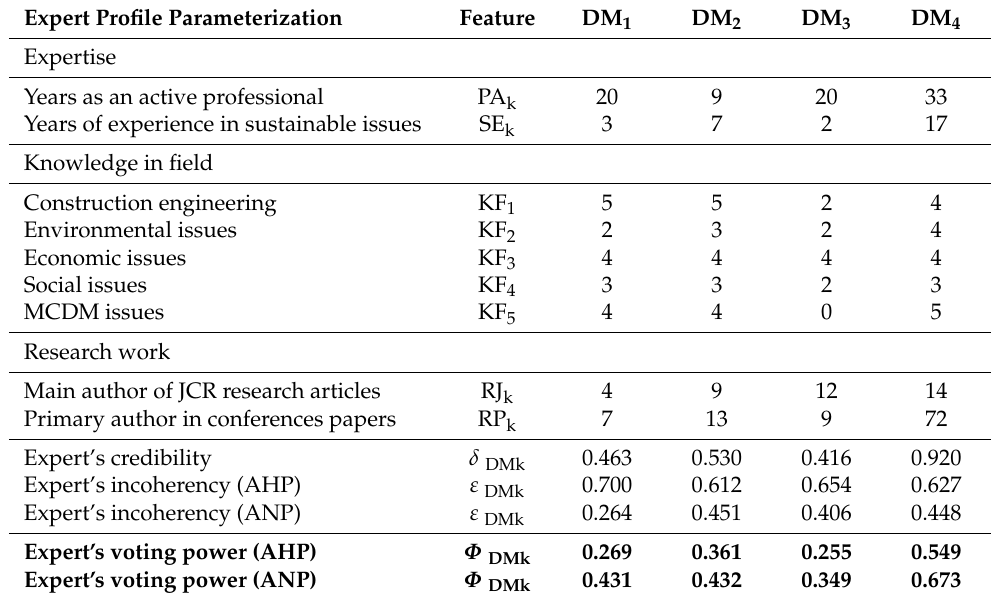
Table A2. Characterization and voting power of the experts of the AHP/ANP group.